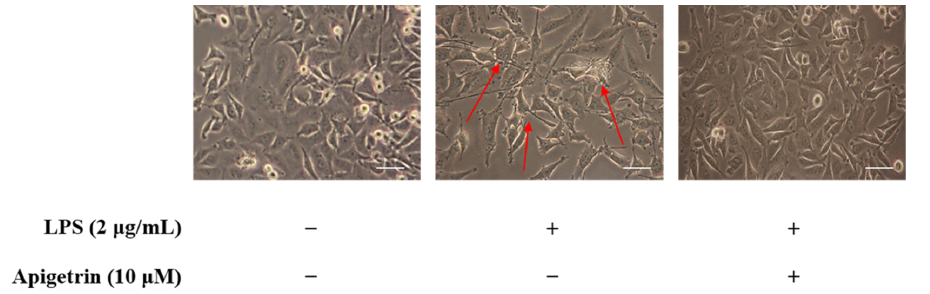
Figure 2. Morphological changes of L6 cells. Changes were observed after 24 h of treatment with apigetrin (0 and 10 μM), with or without LPS (2 μg/mL), at indicated concentrations. The observa- apigetrin (0 and 10 µ M), with or without LPS (2 µ g/mL), at indicated concentrations. The observations tions were carried out with the aid of a light phase-contrast microscope (×200). were carried out with the aid of a light phase-contrast microscope ( ×